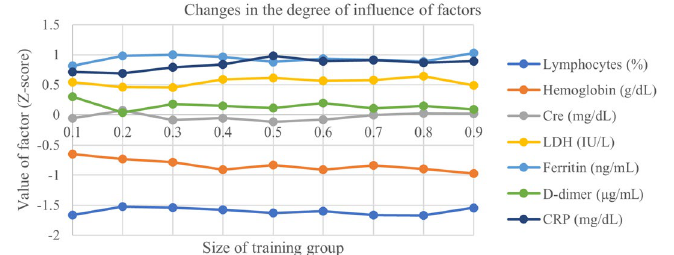
Figure 1. Association between the degree of influence of each factor according to the size of the training group. Cre, Creatine; CRP, C-reactive protein; LDH, lactate